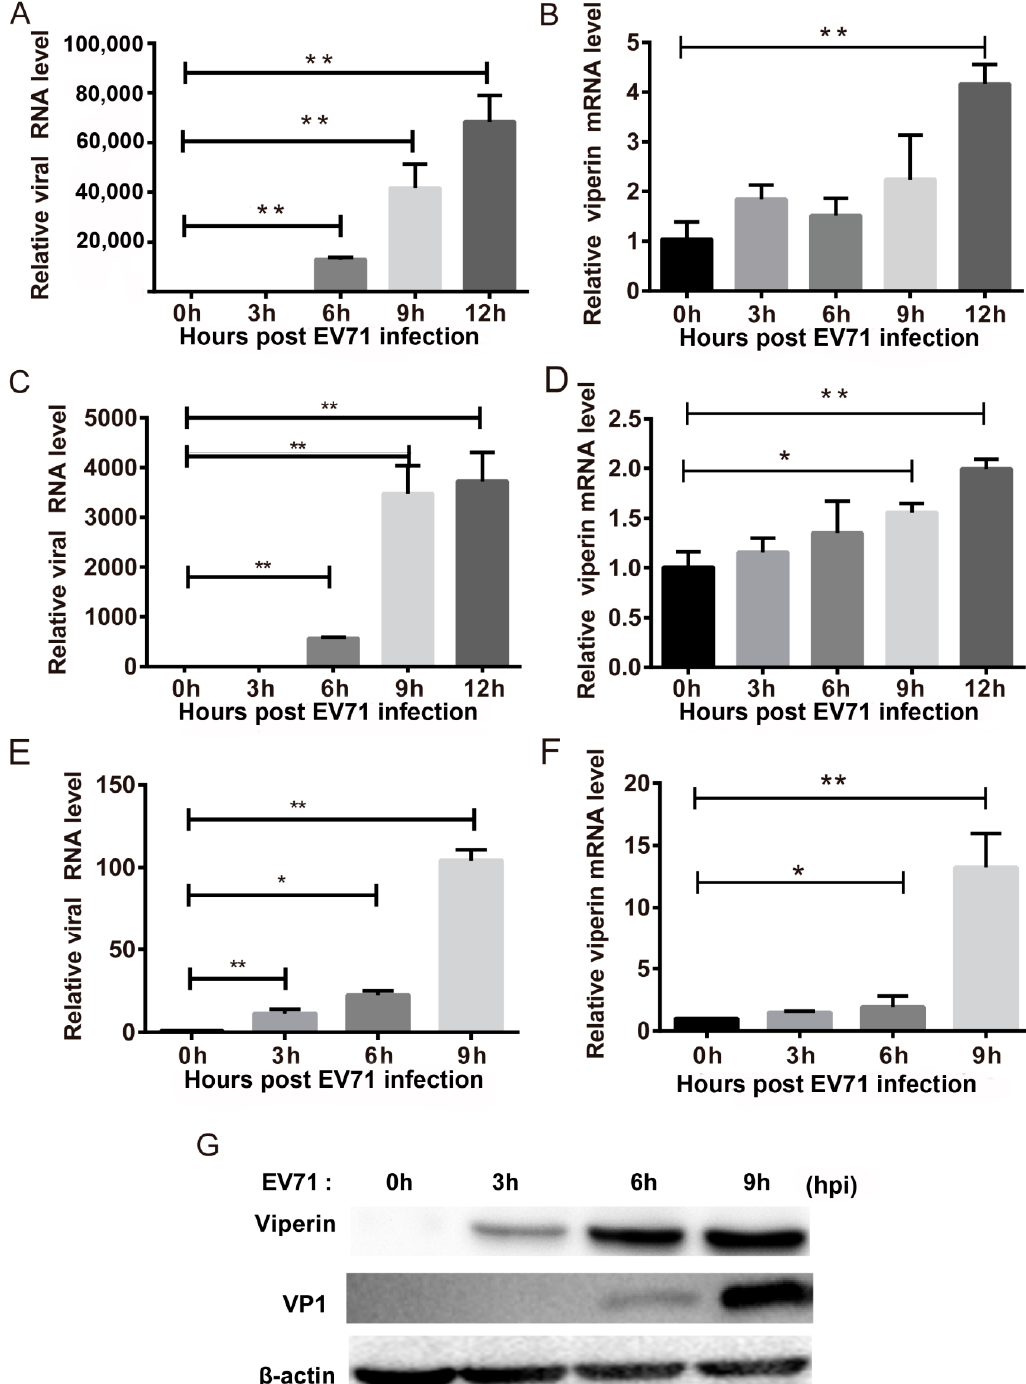
Figure 1. EVA71 induces viperin expression in vitro. ( A , B ) RD, ( C , D ) SK-N-SH, and ( E , F ) CCF-STTG1 cells were infected with EVA71 at a multiplicity of infection (MOI) = 1 for the indicated time points. The relative expression of viperin was detected using quantitative polymerase chain reaction (q-PCR) using glyceraldehyde 3-phosphate dehydrogenase (GAPDH) as the control. After the cells were infected with EVA71 at an MOI = 1, levels of viperin mRNA and viral RNA of EVA71 were detected using real-time q-PCR at the indicated time points. Data are representative of at least three independent experiments performed in triplicate (mean ± SD of fold change). * p < 0.05 and ** p < 0.01. ( G ) Western blot analysis of viperin protein, VP1 protein, and β -actin of EVA71-infected CCF-STTG1 cells at the indicated time